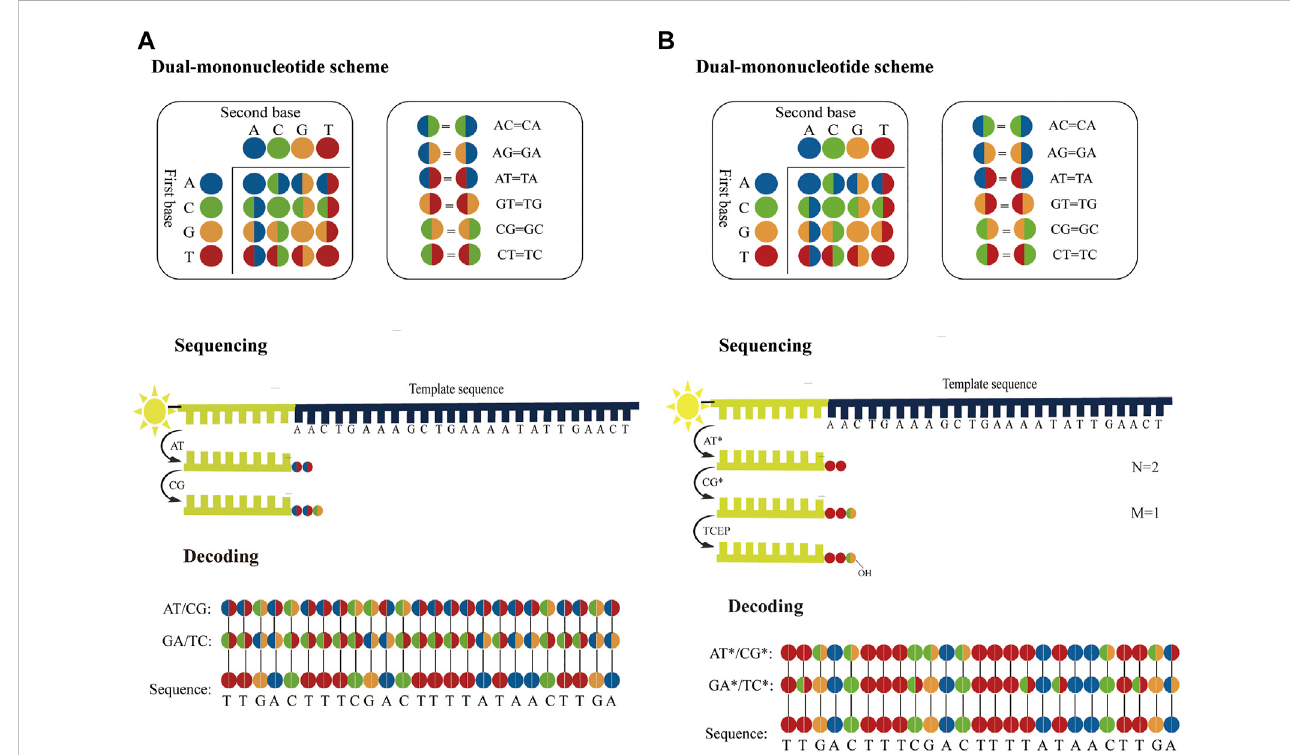
FIGURE 5 Schematicsofdual-basesequencingbasedon SBS. (A) Theschematicofreal-time decodingsequencingtechnology. Amixtureoftwobasesisaddedto areactioncycle.Thedual-basemixtureallowsanycomplementarybasestobeincorporatedtothesyntheticstrand,andreleasesanequivalentamountofppi with base extended. When the template is interrogated by using AT/CG and GA/TC in two parallel sequencing runs, two sets of encodings can be obtained, fromwhichthesequencecanbededuced. (B) Theschematicofcorrectabledecodingsequencingtechnology.Thetemplateisinterrogatedbyamixture of two types of nucleotides, natural nucleotide and CRT. Each sequencing cycle consists of nucleotide extension, signal detection and deprotection. In the fi rstextensionreaction,amixtureofAT*isaddedandthenumberofincorporatedbases “ N=2 ” isobtained.Theunbondednucleotidesarethenremovedand another different mixture CG* is added to the second nucleotide addition reaction, and the number of incorporated bases “ M = 1 ” is obtained. In each sequencing run, asetof two-digit stringsNMcan betransformedinto encodings.After thetemplate issequencedtwice with AT*/CG* and GA*/TC*, twosets of encodings are obtained sequentially and the sequence can be also